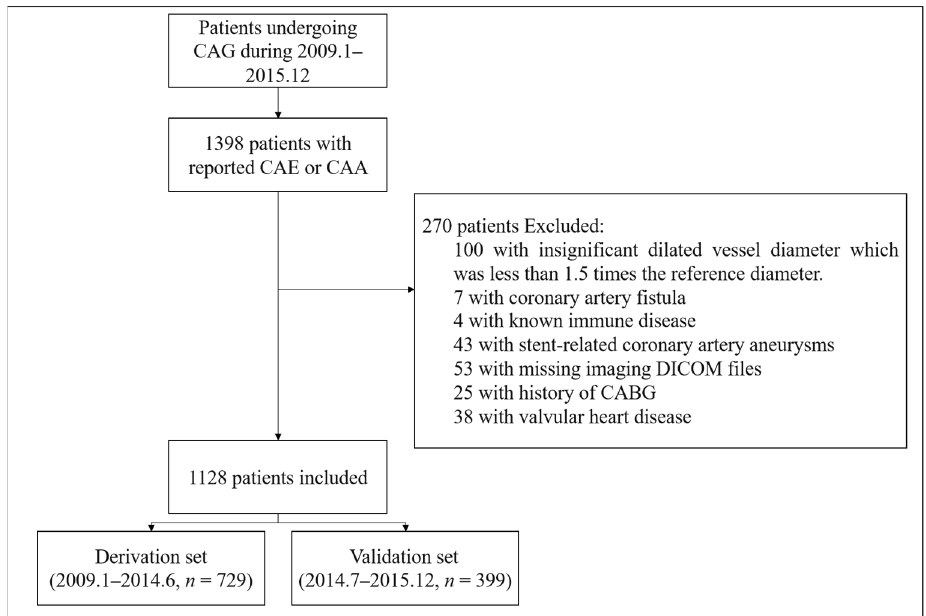
Figure 1. Flowchart of the study objects. CAE: coronary artery ectasia. CAA: coronary artery aneurysm. CAG: coronary angiography.